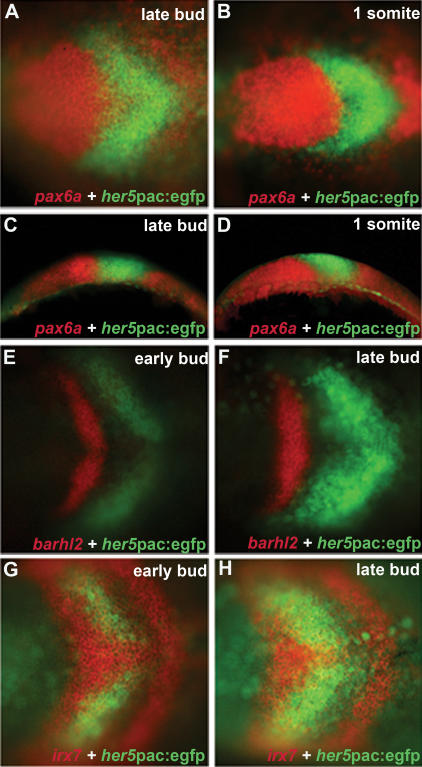
GFP Transgenic Lines Provide Good Landmarks in the Neural Plate(A–D) pax6a (red) and her5pac:egfp (green) are expressed in adjacent neural plate territories at bud stage (A and C) and 1-somite stage (B and D); The same embryos are shown in dorsal (A and B) and lateral views (C and D), rostral to the left. (C and D) show dynamic changes in the neural plate positioning the rostral midbrain dorsal to the caudal diencephalon;(E and F) Dorsal views, rostral to the left of neural plates showing barhl2 (red) and her5pac:egfp (green) expression revealing a shape change of the rostral diencephalon from a mild V-shape (E) at early bud stage to a straight line (F) at late bud stage;(G and H) Dorsal views, rostral to the left of neural plates showing irx7 (red) + her5pac:egfp (green) expression, visualizing the domain of the caudal diencephalon anterior to the midbrain at early bud stage (G) and late bud stage (H).